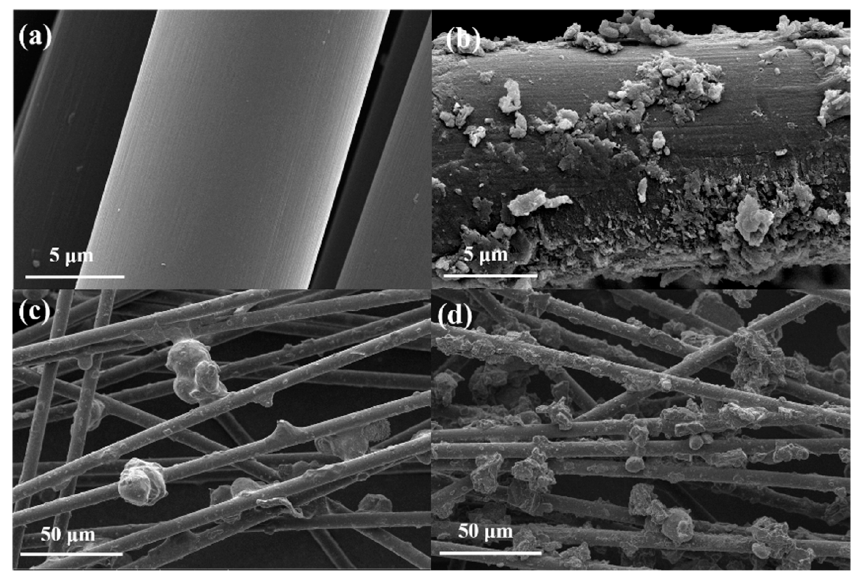
Figure 3. The SEM images of CF, g-C 3 N 4 /CF, and their immobilized enzymes. ( a ) CF; ( b ) g-C 3 N 4 /CF; ( c ) co-immobilized enzymes on CF; ( d ) co-immobilized enzymes on g-C 3 N 4 /CF.